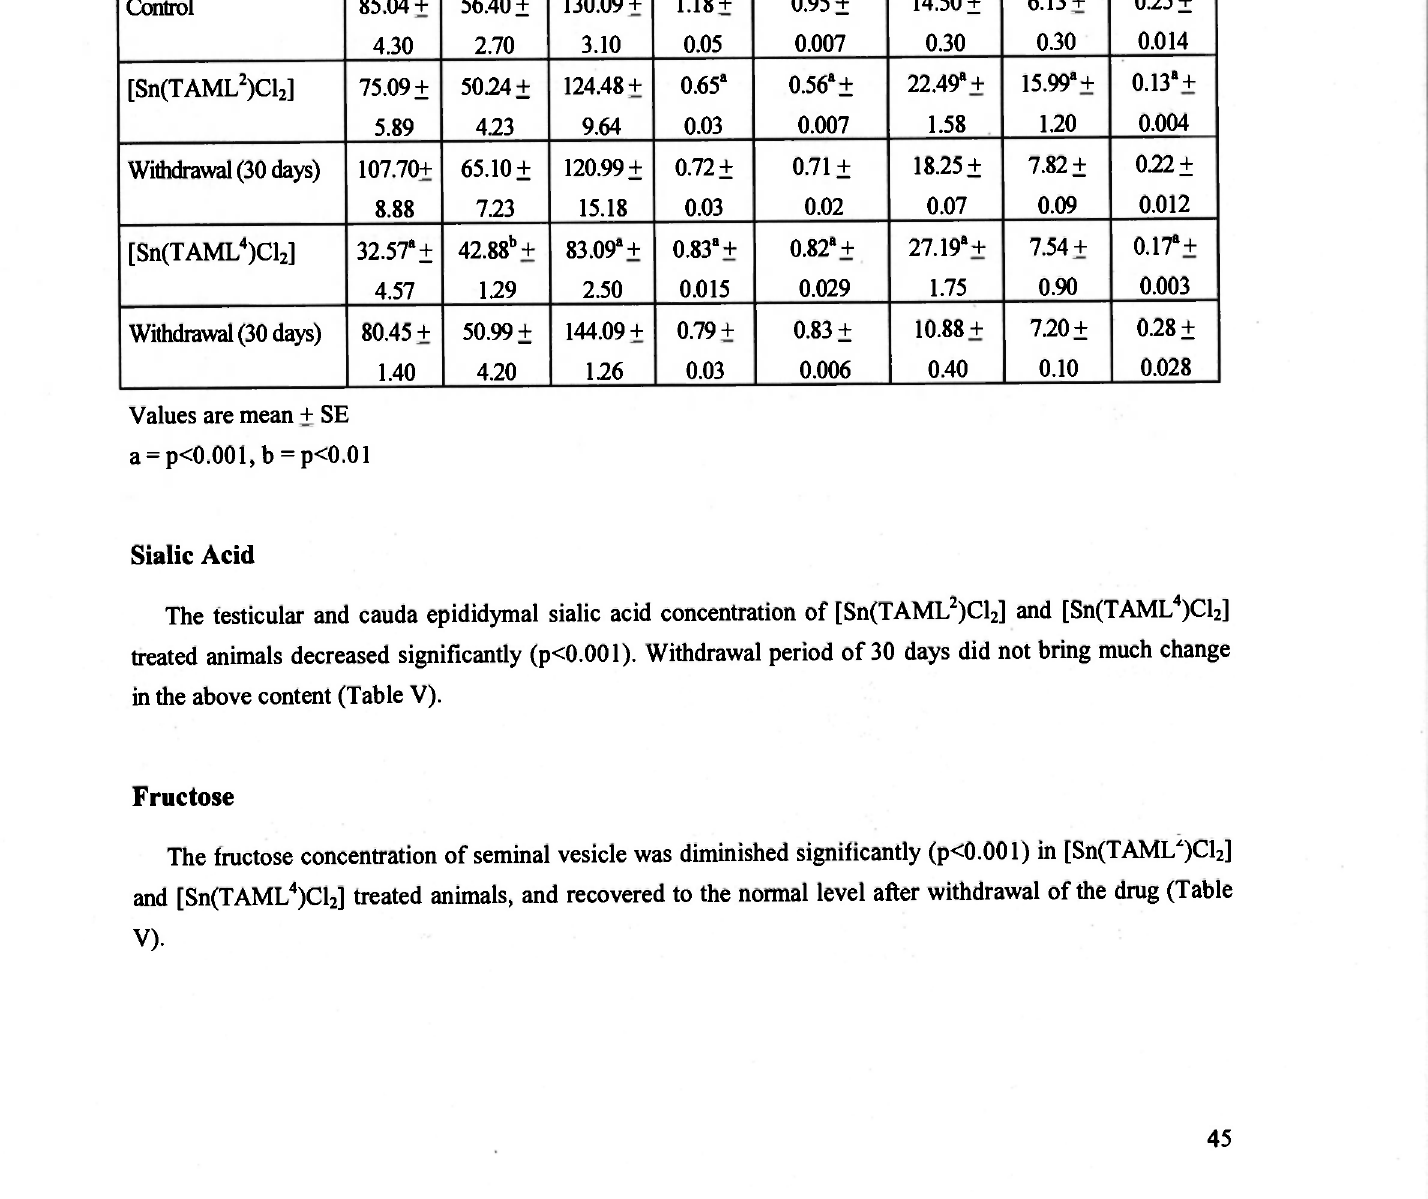
treated and withdrawal group of